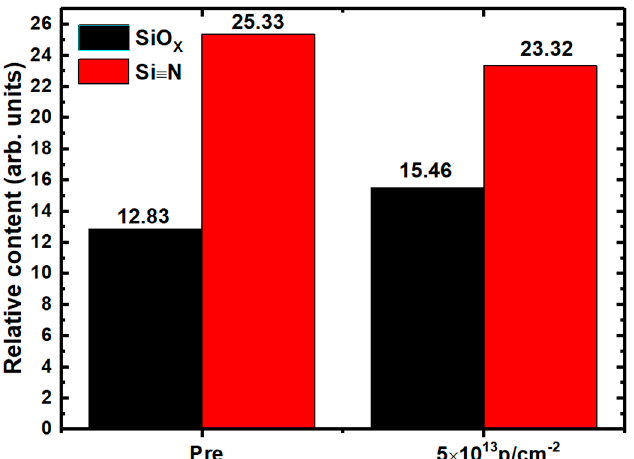
Figure 11. The relative contents of silicon suboxide and silicon nitride in the Si 2p core level spectra of the samples without irradiation and with the irradiation dose of 5 × 10 13 p/cm 2 .